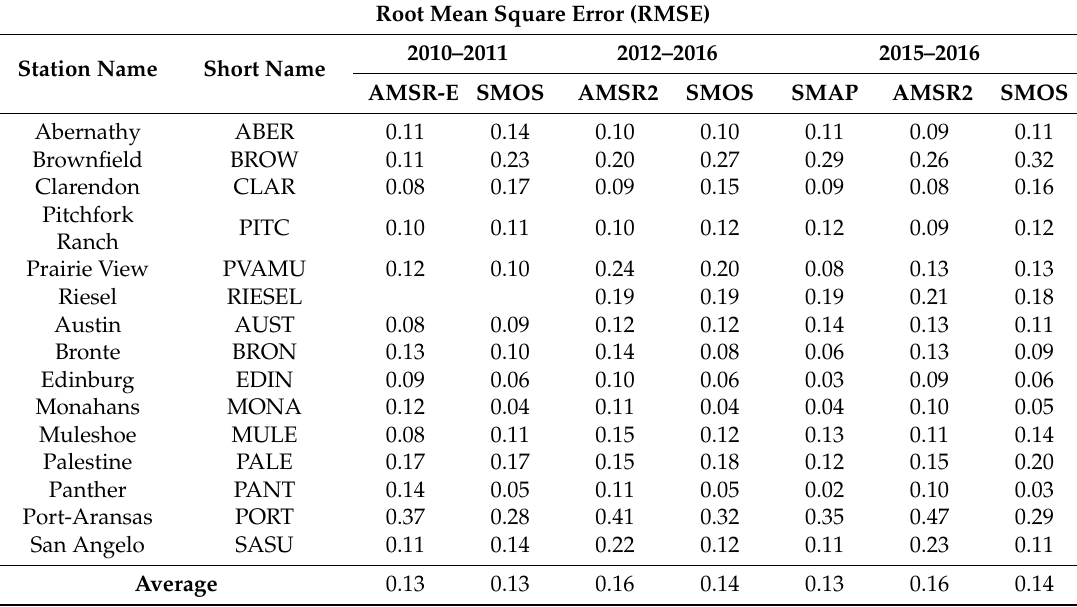
Table 5. Root Mean Square Errors (RMSE) of the correlations among in situ and satellite soil moisture observations during their overlapping periods (state of Texas).